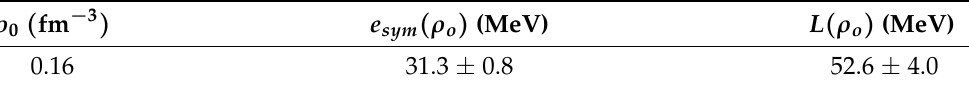
Table 2. The symmetry energy and the slope parameter at N 3 LO at saturation density ρ o . L is defined as in Equation